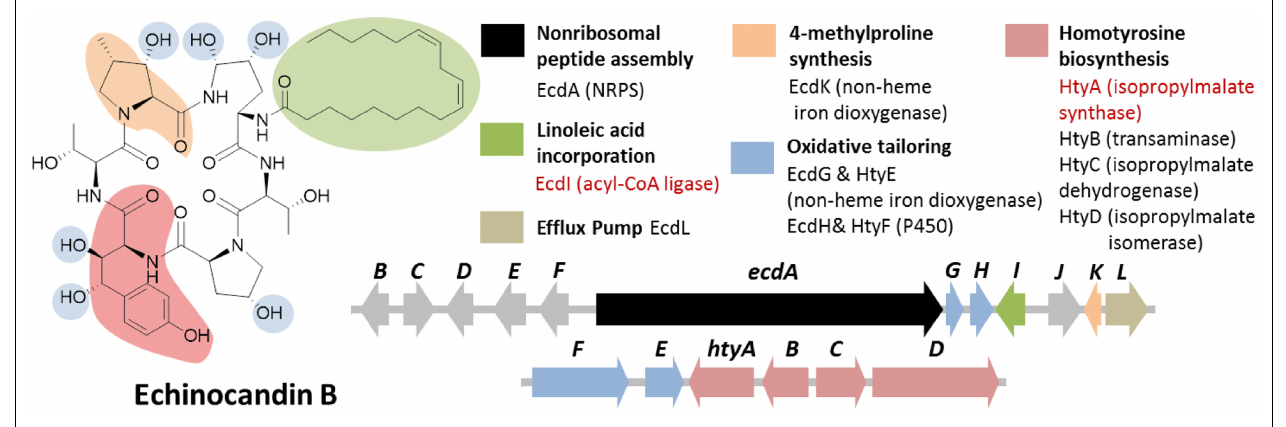
FIGURE 7 | Echinocandin B biosynthetic gene cluster in E. rugulosa . The gene cluster was found in two loci ( ecd and hty ). The ecd cluster contained a six module NRPS gene ecdA and an acyl-CoA ligase gene ecdI (in red text), indicating that the gene cluster is